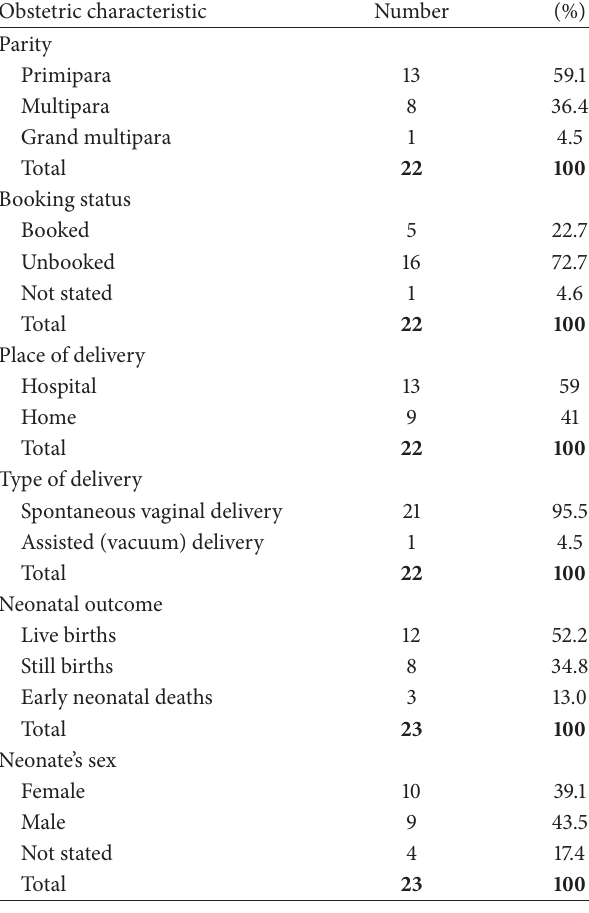
Table 3: Obstetric characteristics of the patients.